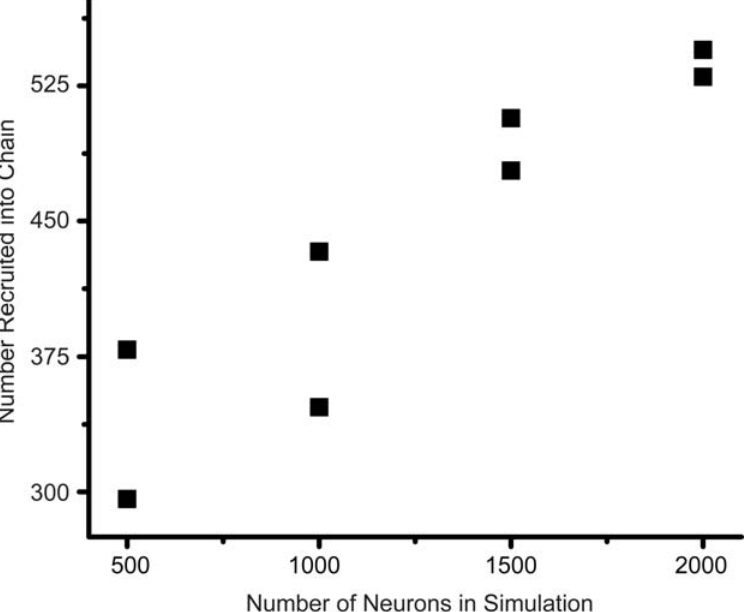
Figure 6. Size of developed network versus the total number of neurons. Simulations were repeated using 500, 1000, 1500, and 2000 neurons. The number of neurons that ended up in the chain were counted and plotted versus the total number of neurons. The relationship is positive.